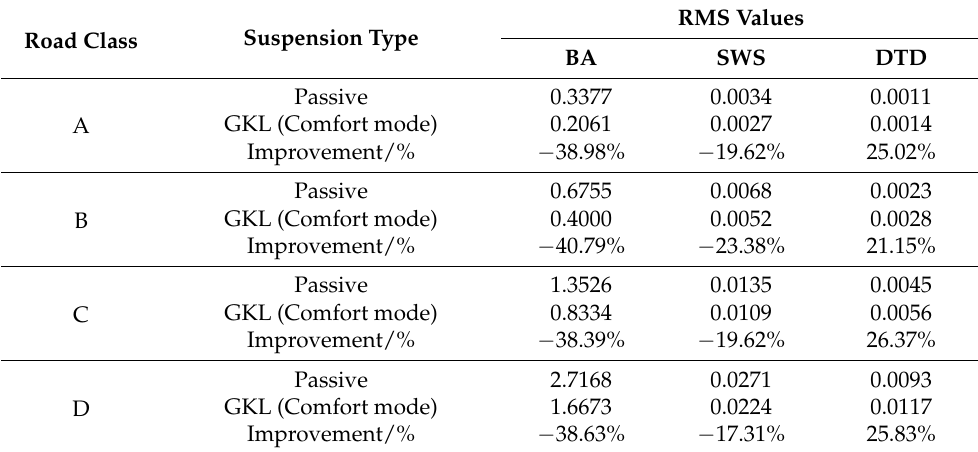
Table 15. RMS values and improvement rate of performance indexes for comfort